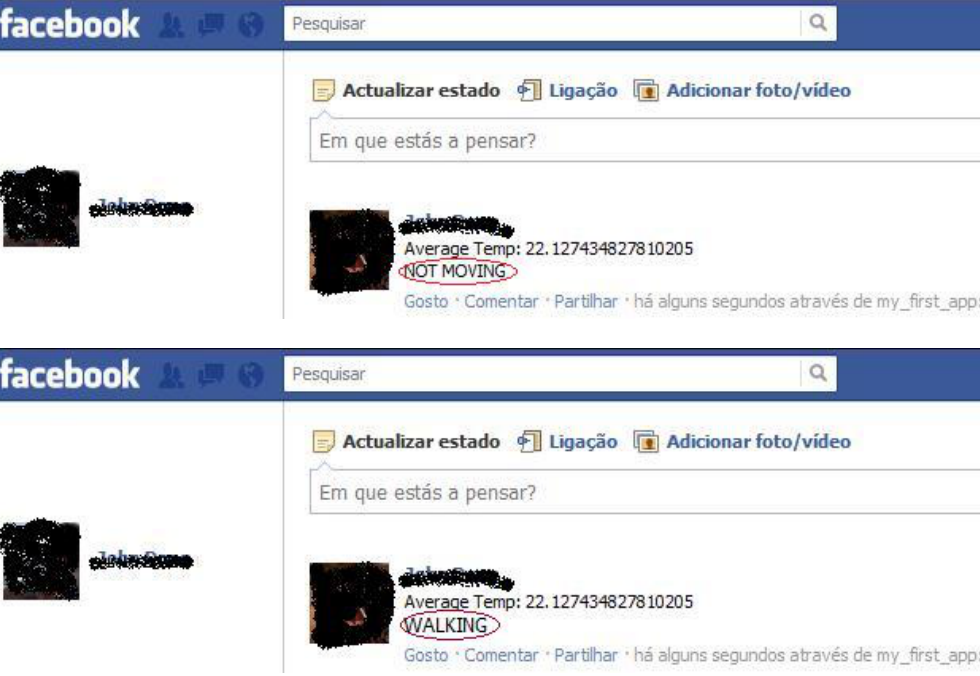
Figure 4. Activity and sensory information are displayed on the Facebook user’s personal